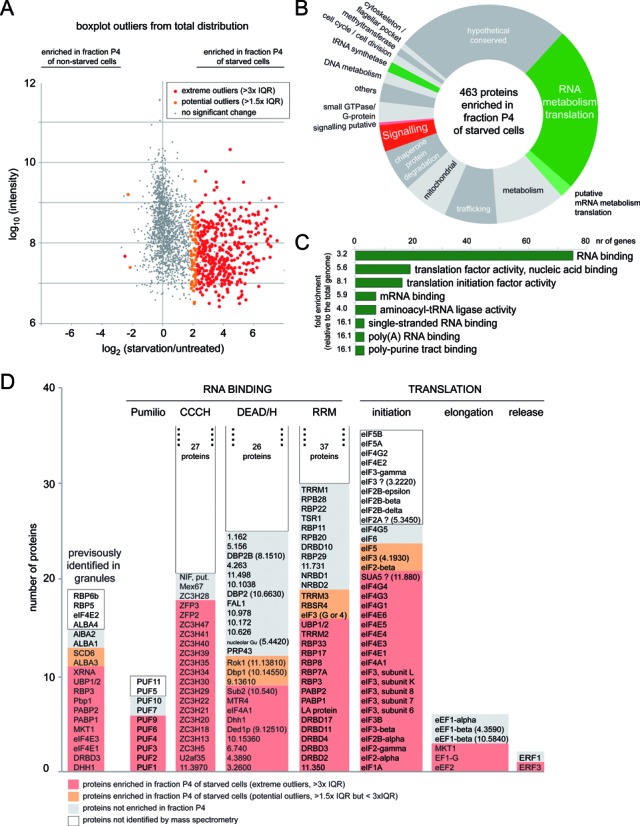
Proteins enriched in starvation stress granules. The ‘granule’ fraction of starved and non-starved cells from three independent experiments was analysed by quantitative, label-free mass spectrometry. (A) Proteins significantly over- or underrepresented in the granule fraction of starved cells are shown in orange (potential outliers) or red (extreme outliers). Plotted is the summed protein intensity (log10 transformed) over the average ratio of protein intensities starved/untreated (log2-tranformed) of at least two of the three biological replicates. (B) The 463 granule granule-enriched proteins were manually classified according to their function, which in most cases is predicted only (Supplementary Table S1). (C) The granule-enriched proteins were analysed for molecular function GO term enrichment (TriTrypDB, (56)). All GO terms that were at least three times enriched in comparison to all proteins encoded in the genome and had a P-value of <0.01 are shown. In some cases similar GO terms were summarized to show only the most specific GO term. (D) Several groups of proteins that are likely to localize to RNP granules (previously identified, RNA binding domains, eukaryotic translation factors) were analysed for their content in granule-enriched proteins. The proteins are shown with red (extreme outliers) or orange (potential outliers) background if they were among the granule-enriched proteins, with grey background if they were not enriched and with white background if they were not identified in the mass spectrometry. The non-identified proteins of the CCCH, DEAD/H and RRM domain containing proteins are not listed but shown as a total number. For hypothetical proteins the unique gene identifier is shown, excluding ‘Tb927.’.